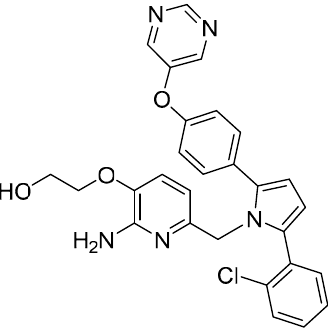
Figure 21. Structure of the improved aminopyridine-base compound 24 developed by Wyeth.